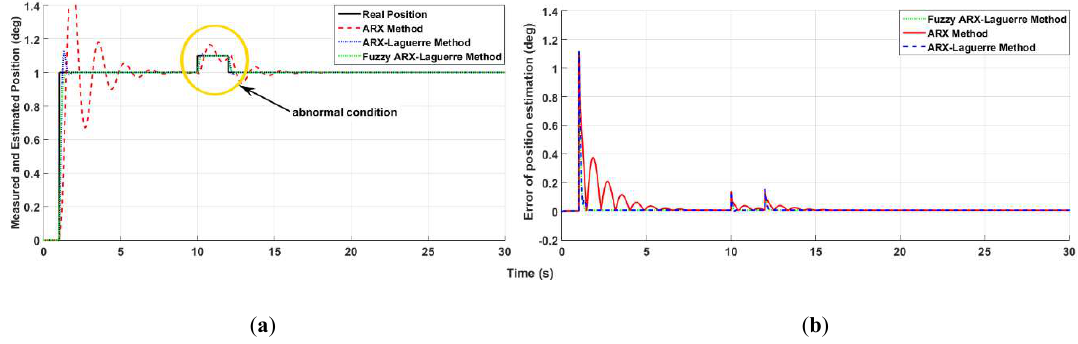
Figure 9. Proposed fuzzy ARX-Laguerre method, ARX-Laguerre technique, and ARX algorithm